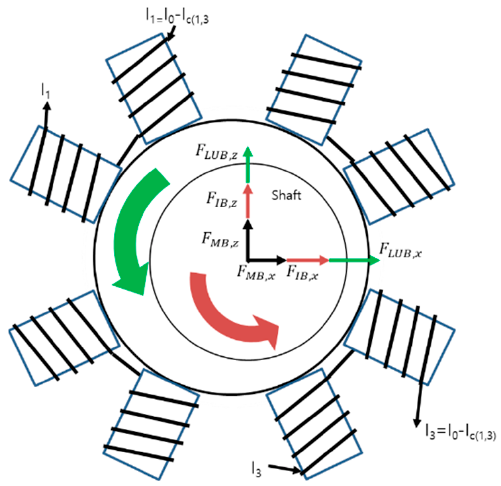
Figure 15. Free body diagram of the rotating shaft under AMB control.